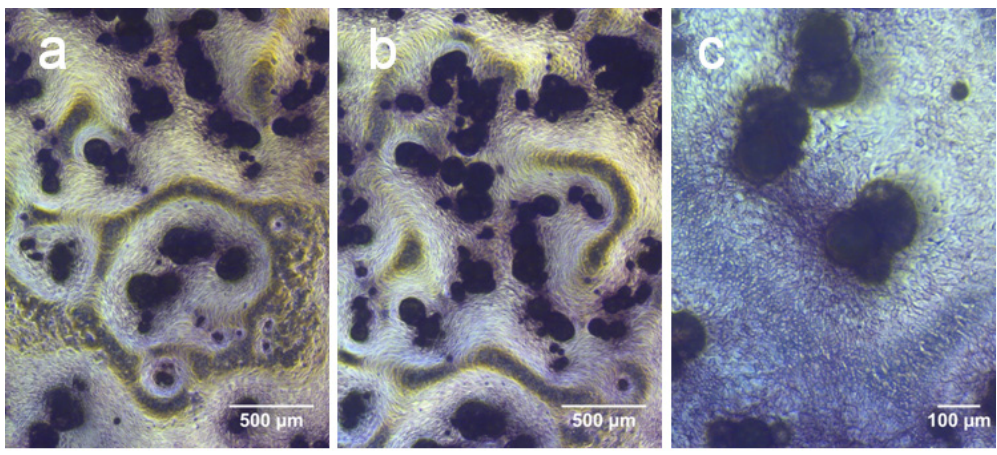
Figure 7. Representative optical microscopy images showing MC3T3-E1 cell depositions stained with alizarin red after culture with BMP-2 loaded PLGA/PLGA-PEG-PLGA microparticles for 10 days. A heterogeneous staining follows the contours of the microparticles. Images show magnifications at 2× ( a and b ) and 20× ( c